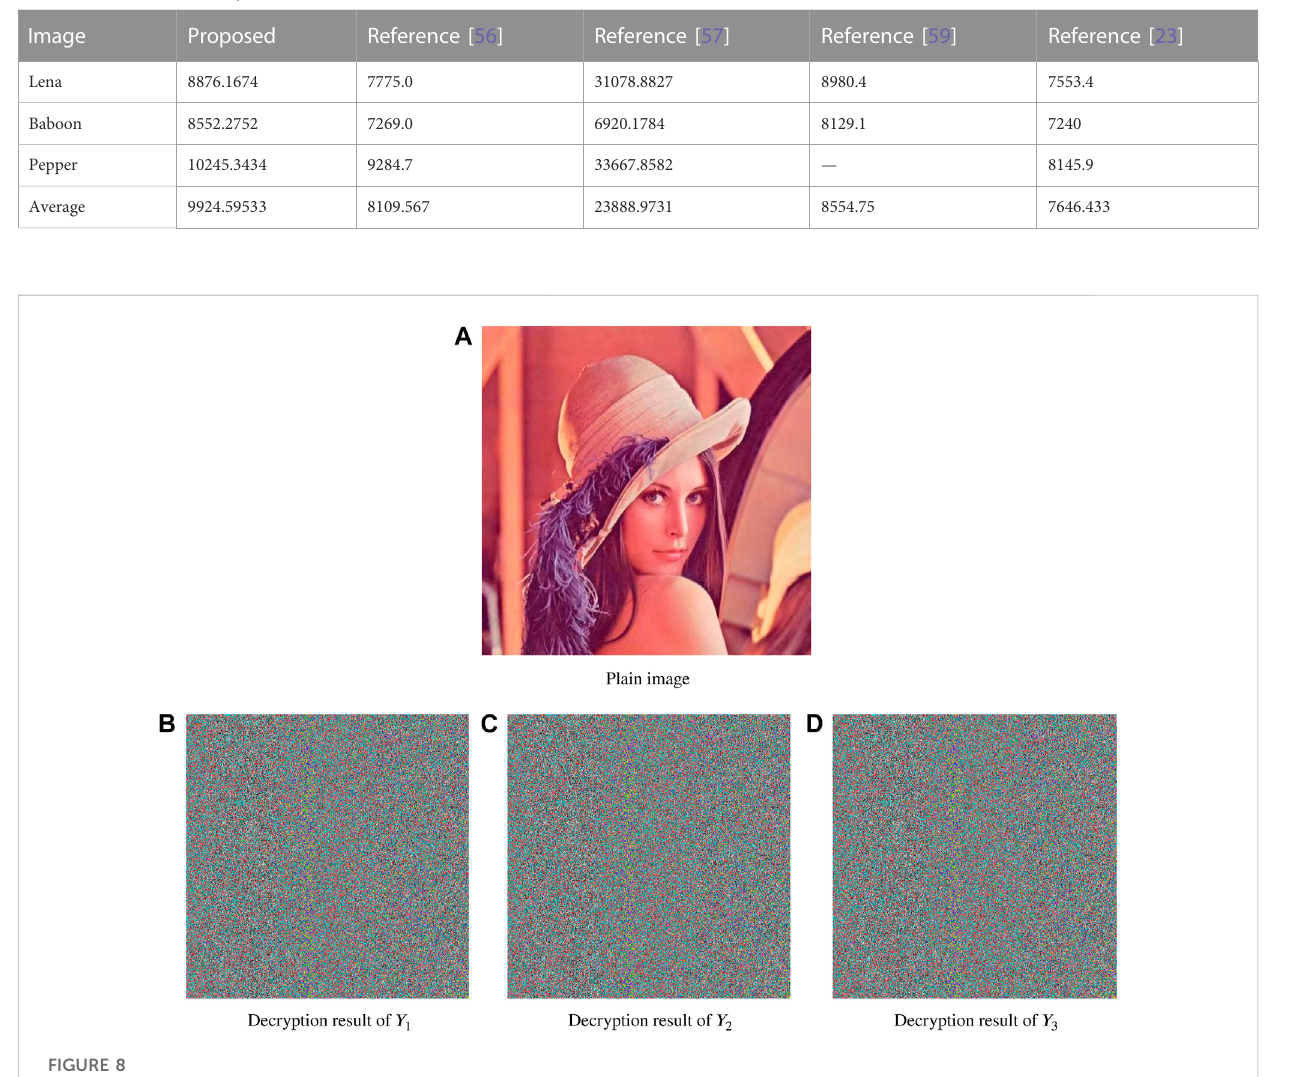
TABLE 5 Result of MSE analysis.